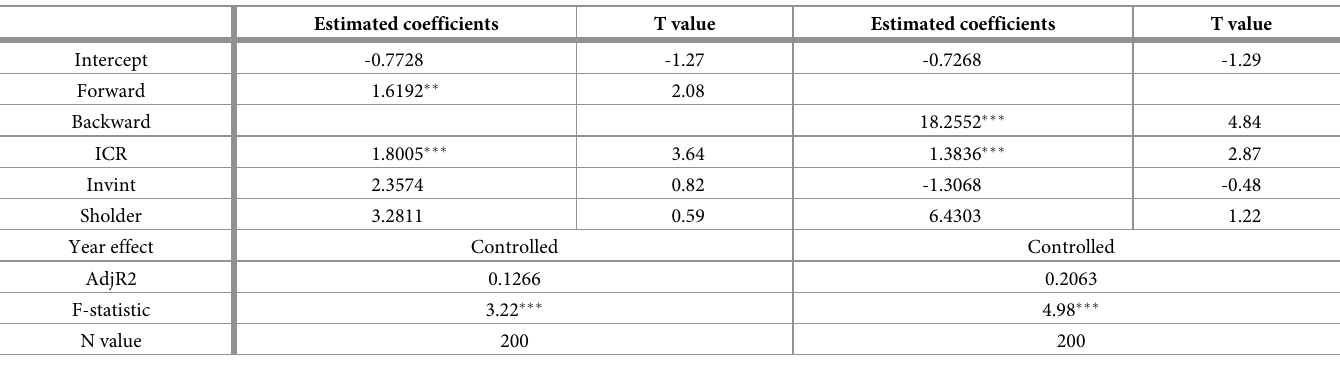
Table 3. Vertical integration and ICSR regression results.